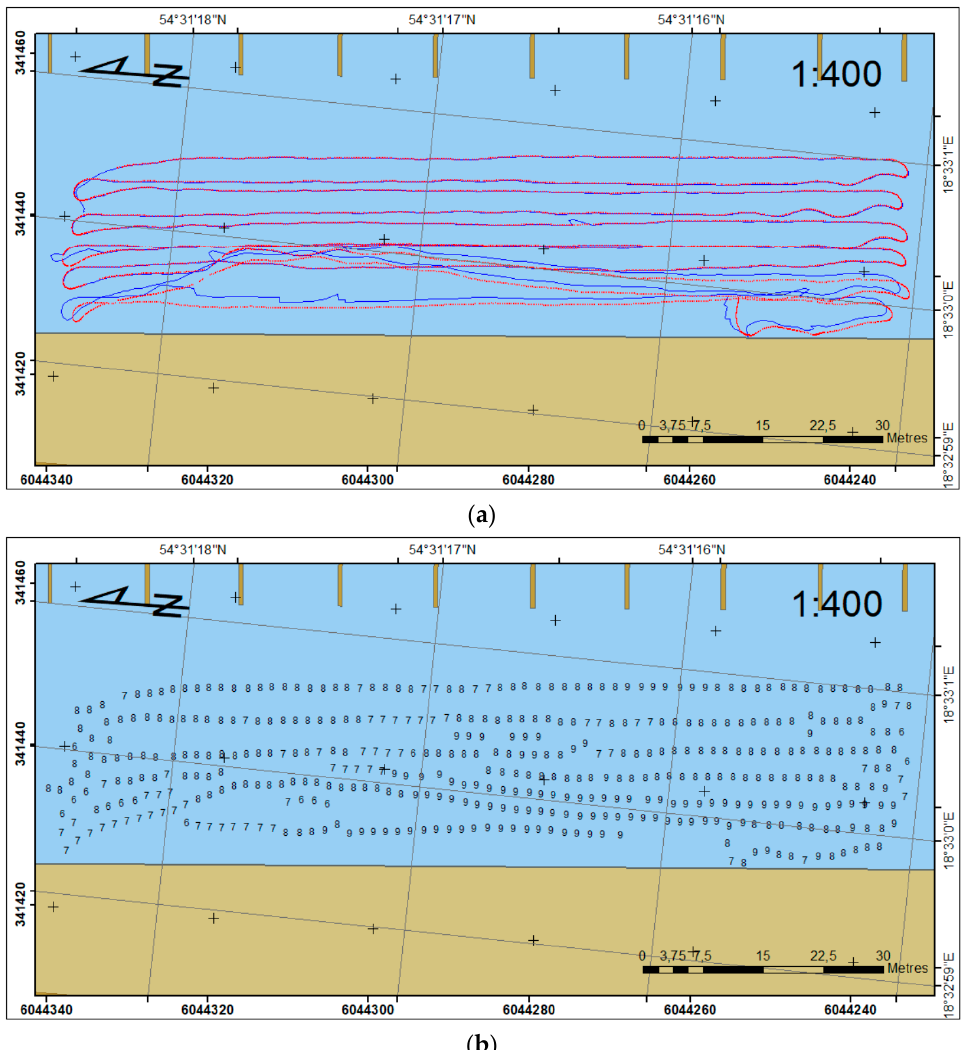
Figure 5. USV trajectory ( a ), total number of used satellites ( b ) for USV positioning (GPS only).